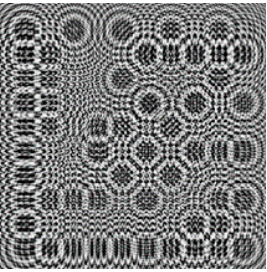
Figure 4. Synthesized kinoform fringe pattern.